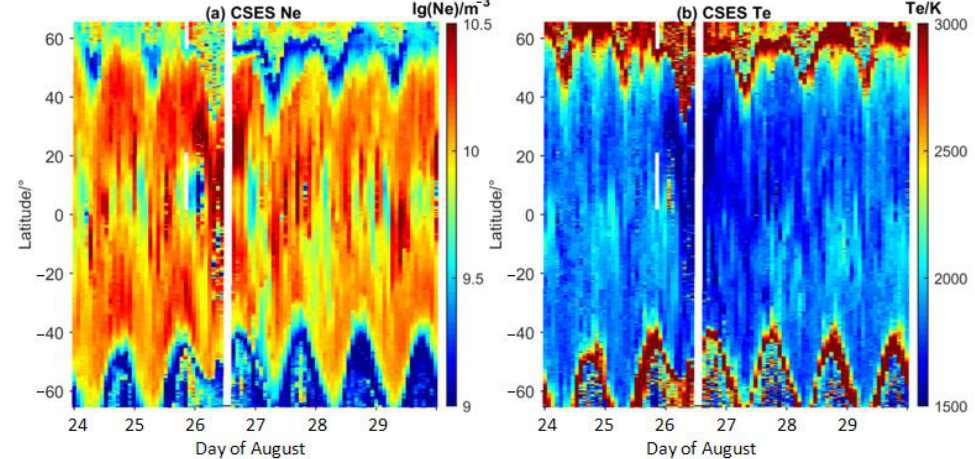
Figure 5. The electron density ( a ) and electron temperature ( b ) in local nighttime from 24 to 29 August in 2018.